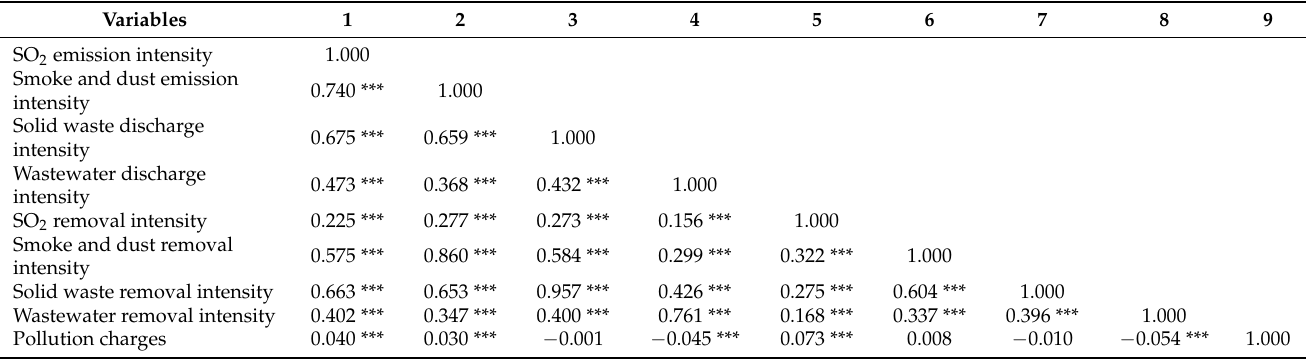
Table 2. Correlation coefficient matrix of major variables in 2012.